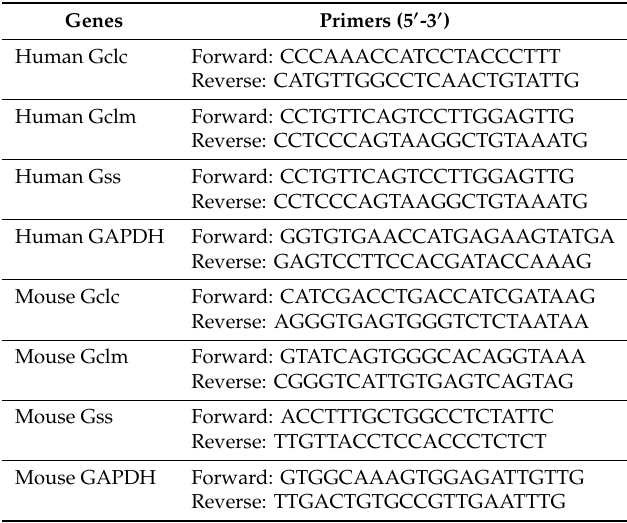
Table 1. Primers used in this